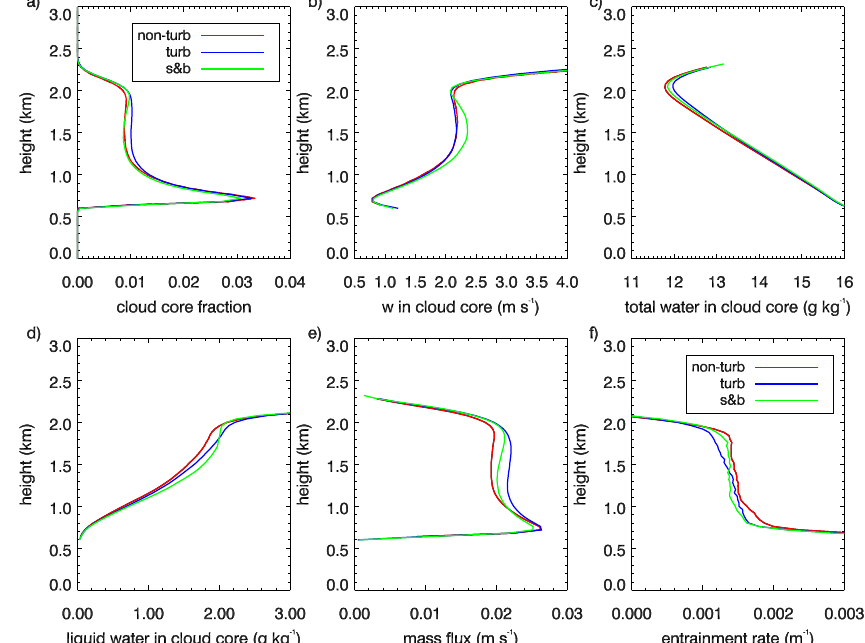
Figure 6. As in Fig. 3 except for (a) cloud core fraction, (b) conditional average of vertical velocity inside cloud cores (ms − 1 ) , (c) conditional average of total water inside cloud cores (gkg − 1 ) , (d) conditional average of cloud liquid water in cloud cores (gkg − 1 ) , (e) mass flux (ms − 1 ) , and (f) entrainment rate (m − 1 ) .